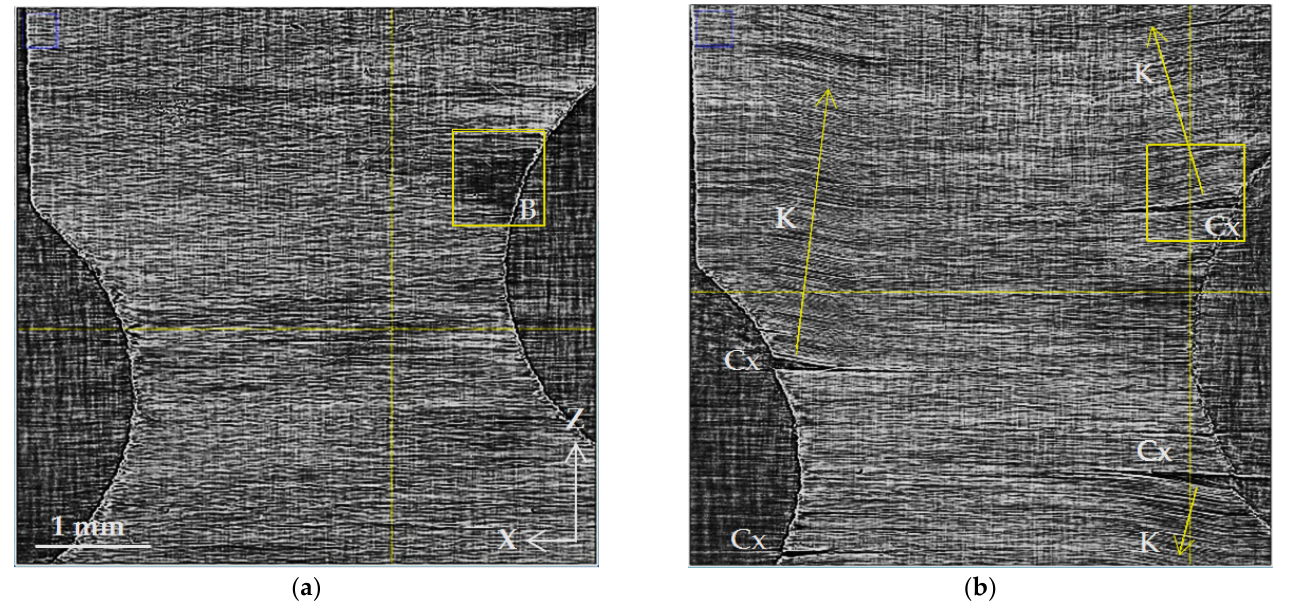
Figure 5. Microstructure of cross-ply CFR plastic at the interface of adjacent [90/90] layers: ( a ) initial state, 38 MPa; ( b ) loaded state, 865 MPa. B—binder pocket; Cx—crack spreading along the X-axis; K—kinking of fiber package.